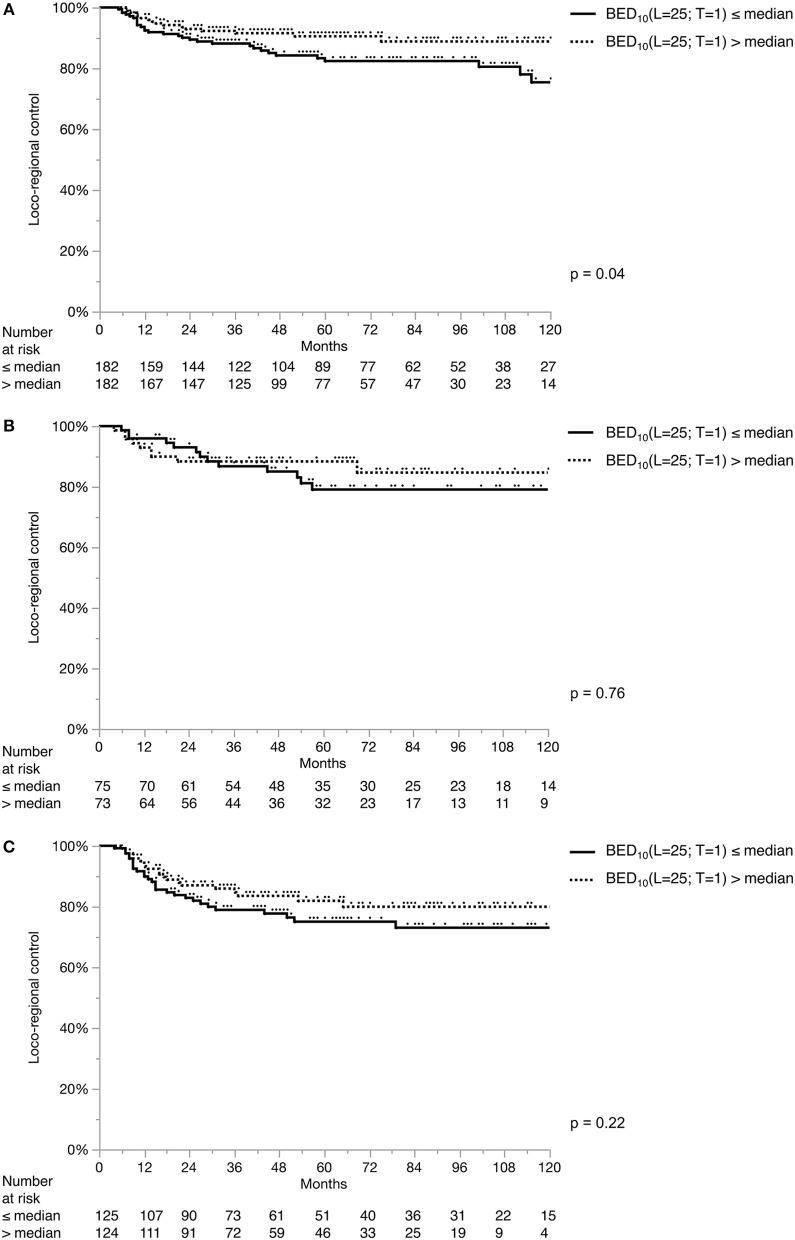
Loco-regional control separated by median BED10(L = 25; T = 1). Loco-regional control in T1a (A), T1b (B), and T2 (C) tumors. Each stage subgroup is dichotomized with its own median value: stage T1a: 60.1 Gy; stage T1b: 61 Gy; stage T2: 64.6 Gy.